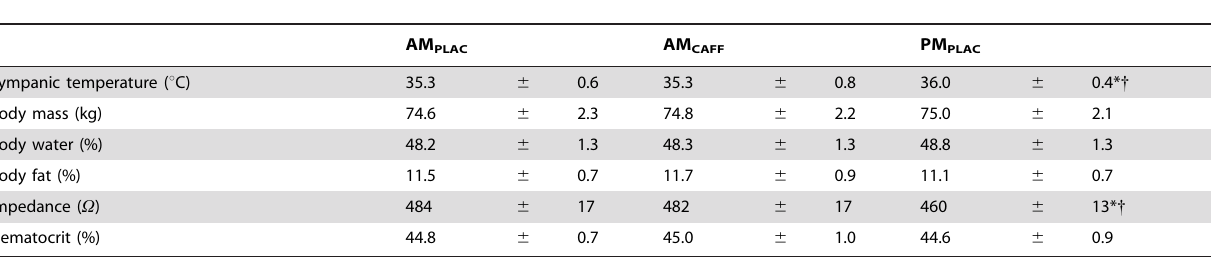
Table 1. Physiological conditions before the